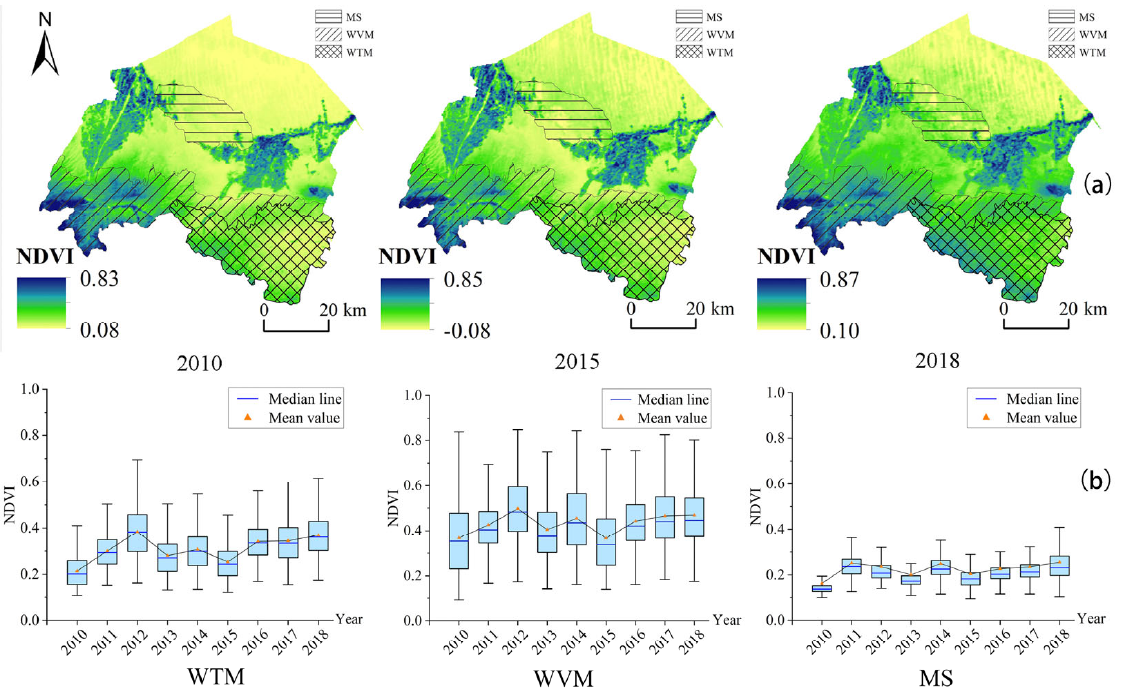
Figure 7. Spatial and temporal distribution of NDVI, 2010–2018: ( a ) Gulang; ( b ) WTM, WVM and MS.